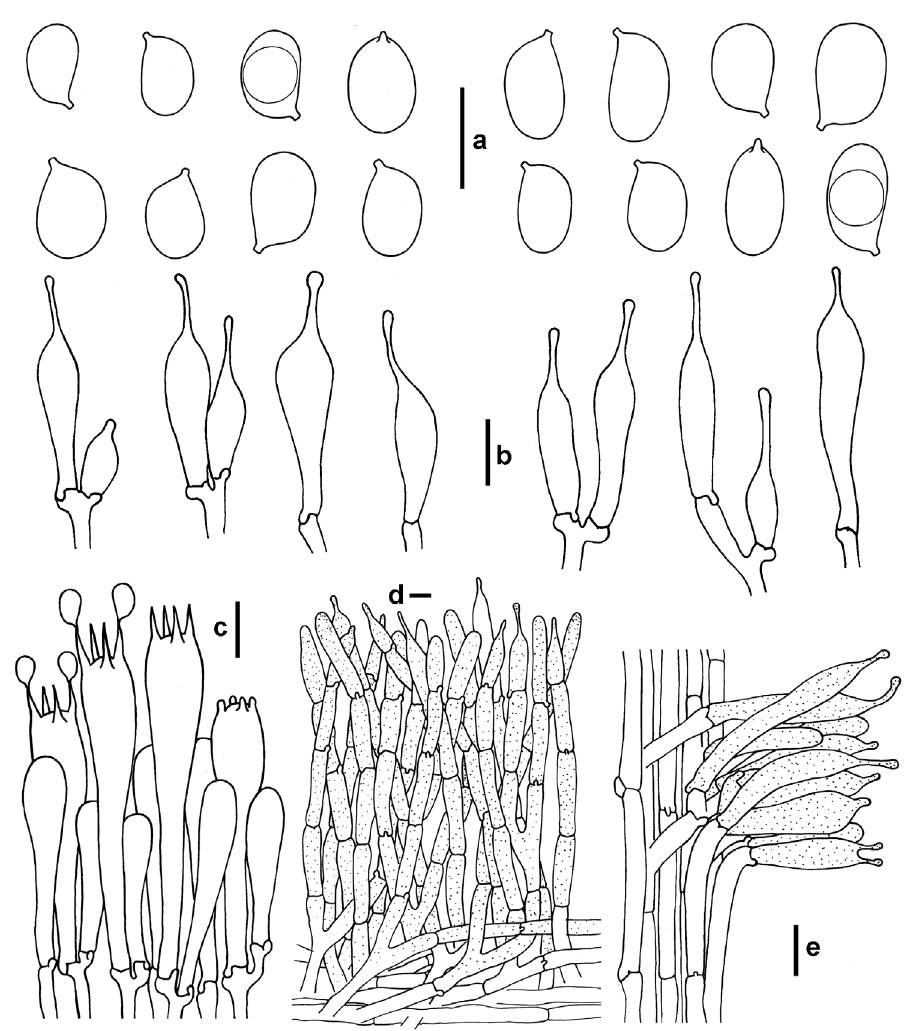
Figure 2. Microscopic features of Cantharocybe virosa (HKAS 79012, Iqbal 568). a Basidiospores b Cheilocystidia c Basidia at different stages of development d Trichoderm pileipellis e Surface of stipe in longitudinal section showing caulocystidia. Scale bars: 10